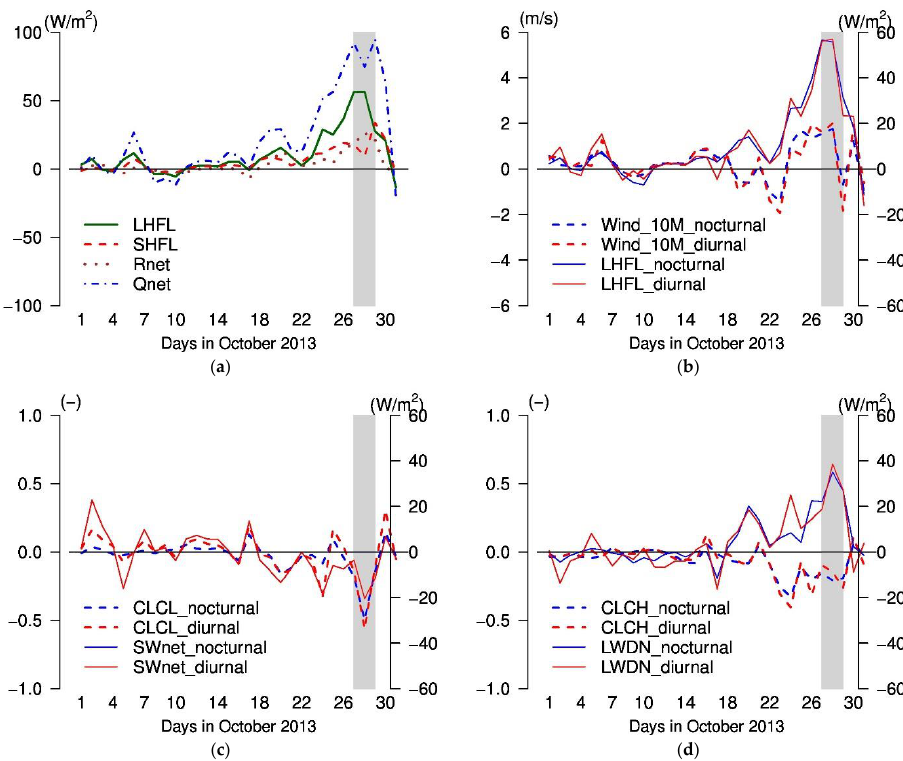
Figure 13. Difference between CCLM1 and CCLM4 of daily mean of ( a ) Surface latent heat flux LHFL, surface sensible heat flux SHFL, net radiation flux Rnet, net energy flux Qnet, ( b ) nocturnal and diurnal Wind_10M and LHFL, ( c ) nocturnal and diurnal low-level cloud cover CLCL and net surface short-wave radiation SWnet, and ( d ) nocturnal and diurnal high-level cloud cover CLCH and surface longwave downward radiation LWDN. Values are averaged over the NwgSea area. Energy fluxes are positive upward. Time period: 1–31 October 2013. The grey bar marks the time of the storm Christian (27–29 October 2013).